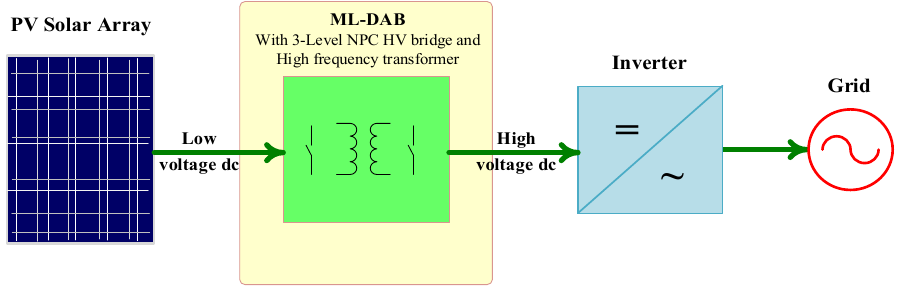
Figure 15. ML-DAB module in a grid-connected photovoltaic (PV) power converter. This ML-DAB can control maximum power point tracking (MPPT) by controlling the phase-shift ( (cid:2038) ) between two active bridges. This topology has the advantage of being modular and replacing the bulky